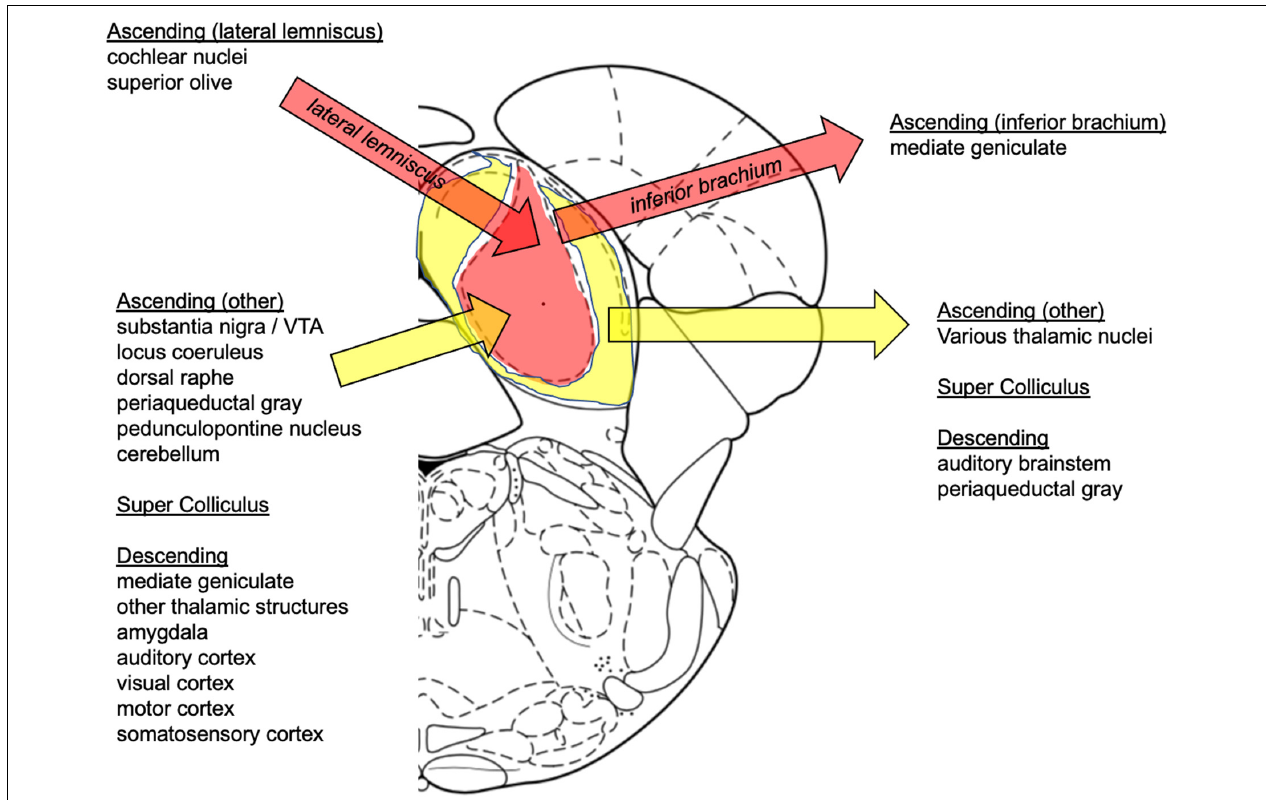
FIGURE 2 | Summary of inferior colliculus afferent and efferent connections. Afferents: Ascending (later lemniscus): cochlear nuclei (Klepper and Herbert, 1991; Cant and Benson, 2006), superior olive (Cant and Benson, 2006), lateral lemniscus (Zhang et al., 1998; Saalmann et al., 2006; Kelly et al., 2009; Chen et al., 2018); Ascending (other): substantia nigra/VTA (Takada et al., 1987; Kemel et al., 1988; Yasui et al., 1991; Deniau and Chevalier, 1992; Moriizumi et al., 1992), locus coeruleus (Klepper and Herbert, 1991; Hormigo et al., 2012), dorsal raphe (Hurley and Pollak, 2001; Hurley, 2006; Hurley and Sullivan, 2012), pedunculopontine nucleus (Noftz et al., 2020), periaqueductal gray (Dujardin and Jürgens, 2005), cerebellum (Huffman and Henson, 1990); Super Colliculus (Adams, 1980; Clerici and Coleman, 1987; Stepniewska et al., 2000; Nodal et al., 2005); Descending: medial geniculate (Driscoll and Tadi, 2020), other thalamic structures (Kuwabara and Zook, 2000), amygdala (Hopkins and Holstege, 1978; Marsh et al., 2002), auditory cortex (Games and Winer, 1988); visual, motor, somatosensory cortices (Cooper and Young, 1976). Efferents: Ascending (inferior brachium): medial geniculate (Oliver, 1984b; Oliver et al., 1991; Peruzzi et al., 1997; Smith et al., 2006); Ascending (other): other thalamic nuclei (Kudo and Niimi, 1980; Senatorov and Hu, 2002; Smith et al., 2006), auditory cortex (Schofield et al., 2011; Xiong et al., 2015; Schofield and Beebe, 2019; Lesicko et al., 2020); Super Colliculus (Van Buskirk, 1983); Descending: auditory brainstem (Huffman and Henson, 1990), periaqueductal gray (Santos et al., 2003; Reimer et al.,